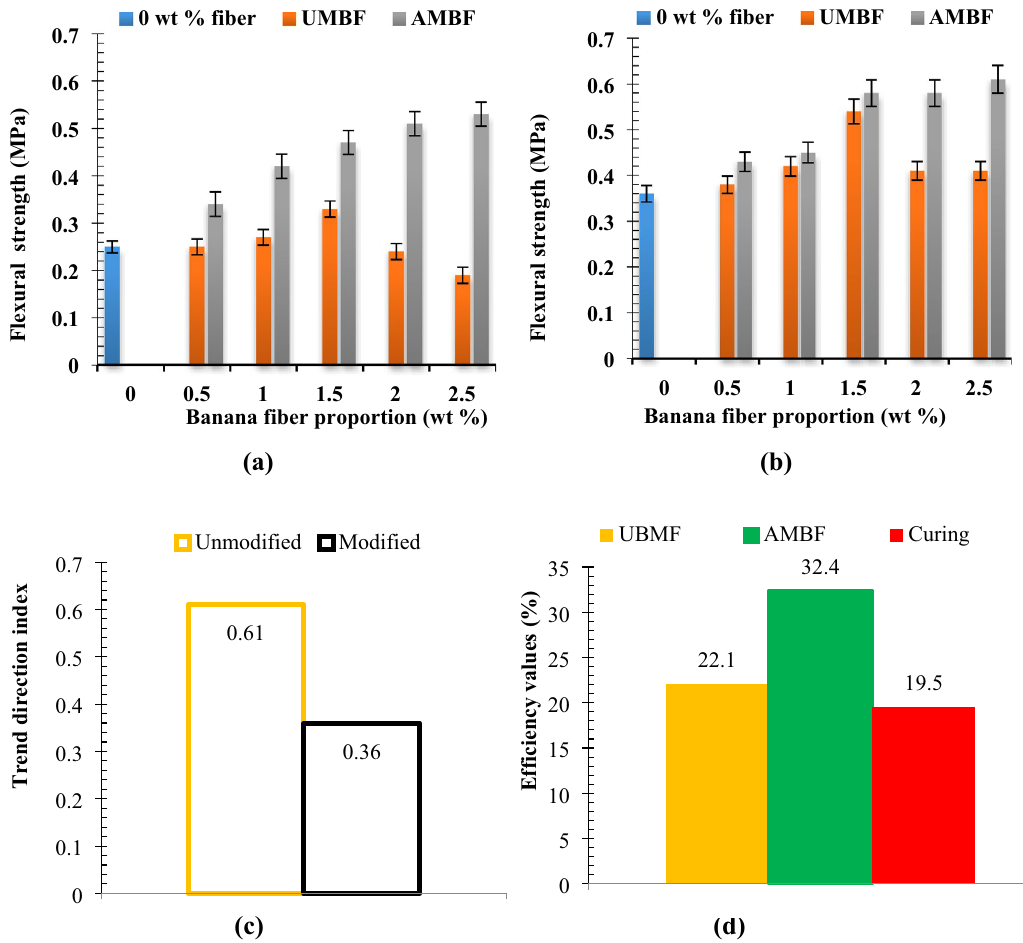
Figure 7. Relation between fiber proportion of unmodified and modified fiber on flexural strength at curing days of ( a ) 28 days and ( b ) 56 days with ( c ) experimental trend analysis and ( d ) property evaluation of experimental